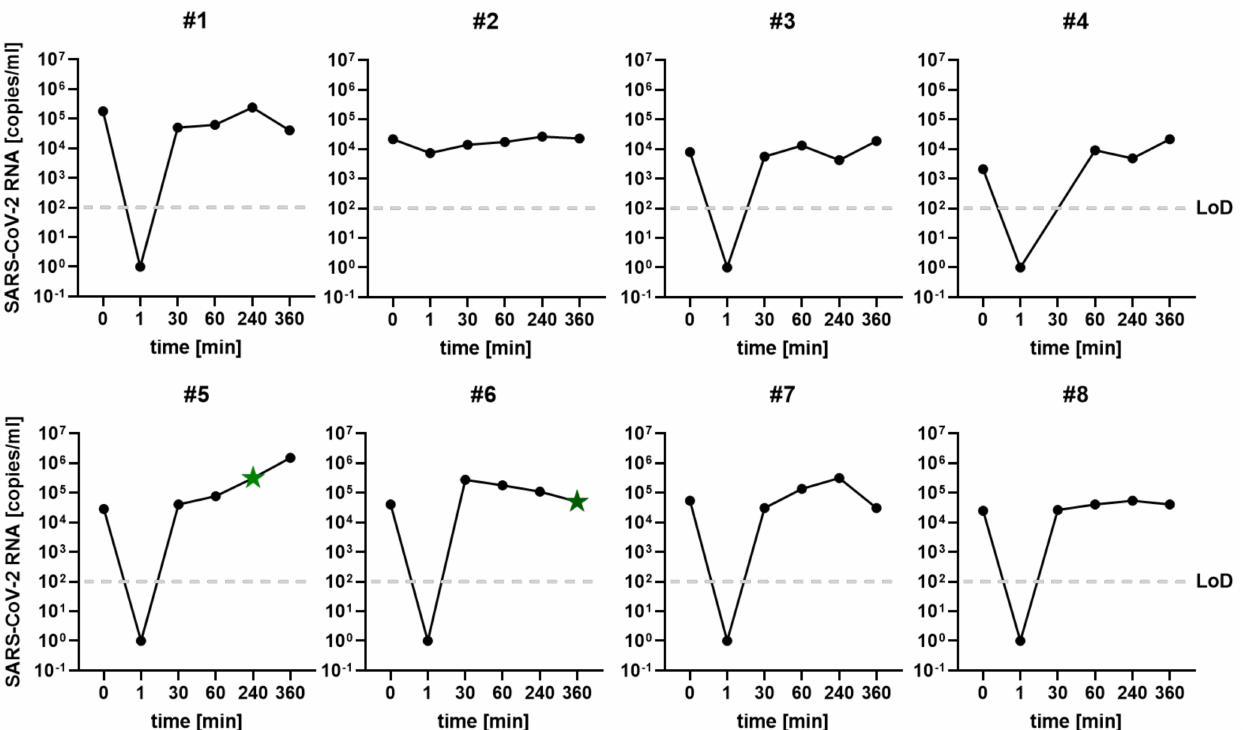
Figure 2. SARS-CoV-2 RNA kinetics of the included 8 subjects: SARS-CoV-2 RNA load [copies/mL] in saliva samples at the analyzed time points is illustrated. The dashed light grey line corresponds to the limit of detection of the RT-qPCR used [14]. The points marked with a green asterisk (time points 240 h subject #5, 360 h subject #6) correspond to infectious samples from which virus isolation was